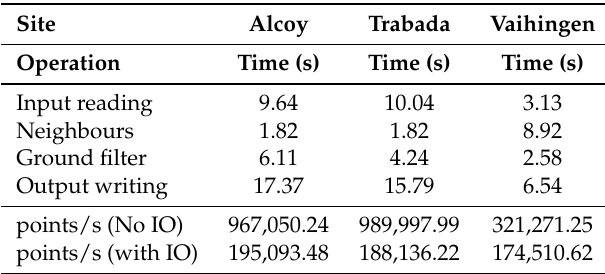
Table 3. Execution times and throughput in the workstation for the Alcoy (6 million points), Trabada (6 million points), and Vaihingen (3.77 million points) data with and without considering input and output